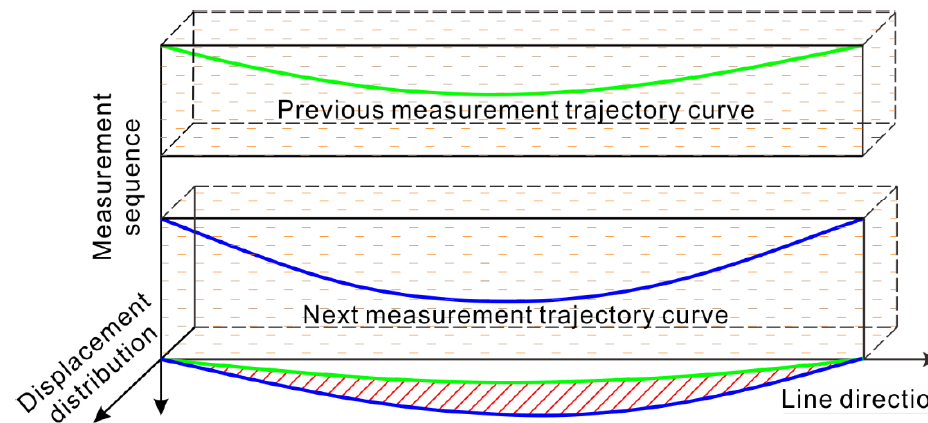
Figure 2. Schematic diagram of the change in the buried pipeline trajectory reflecting the displacement distribution of the landslide body.